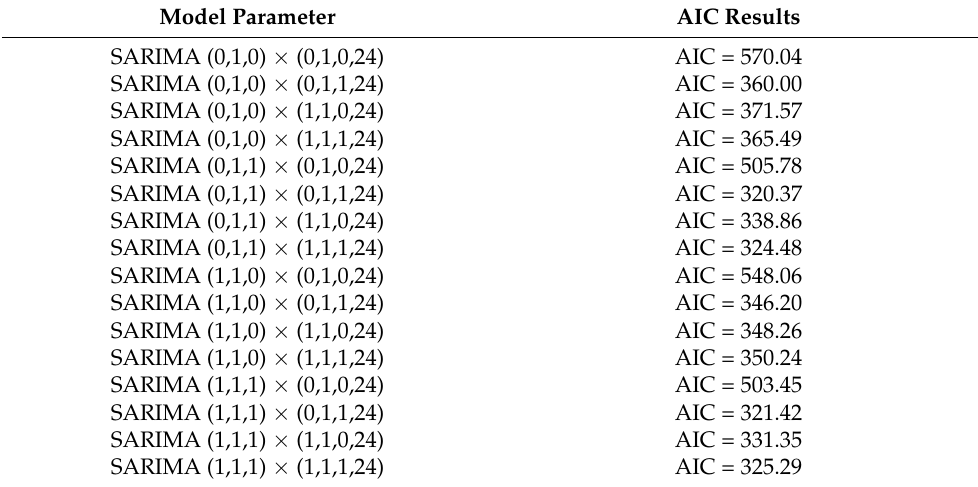
Table 3. AIC calculation results of offset azimuth.